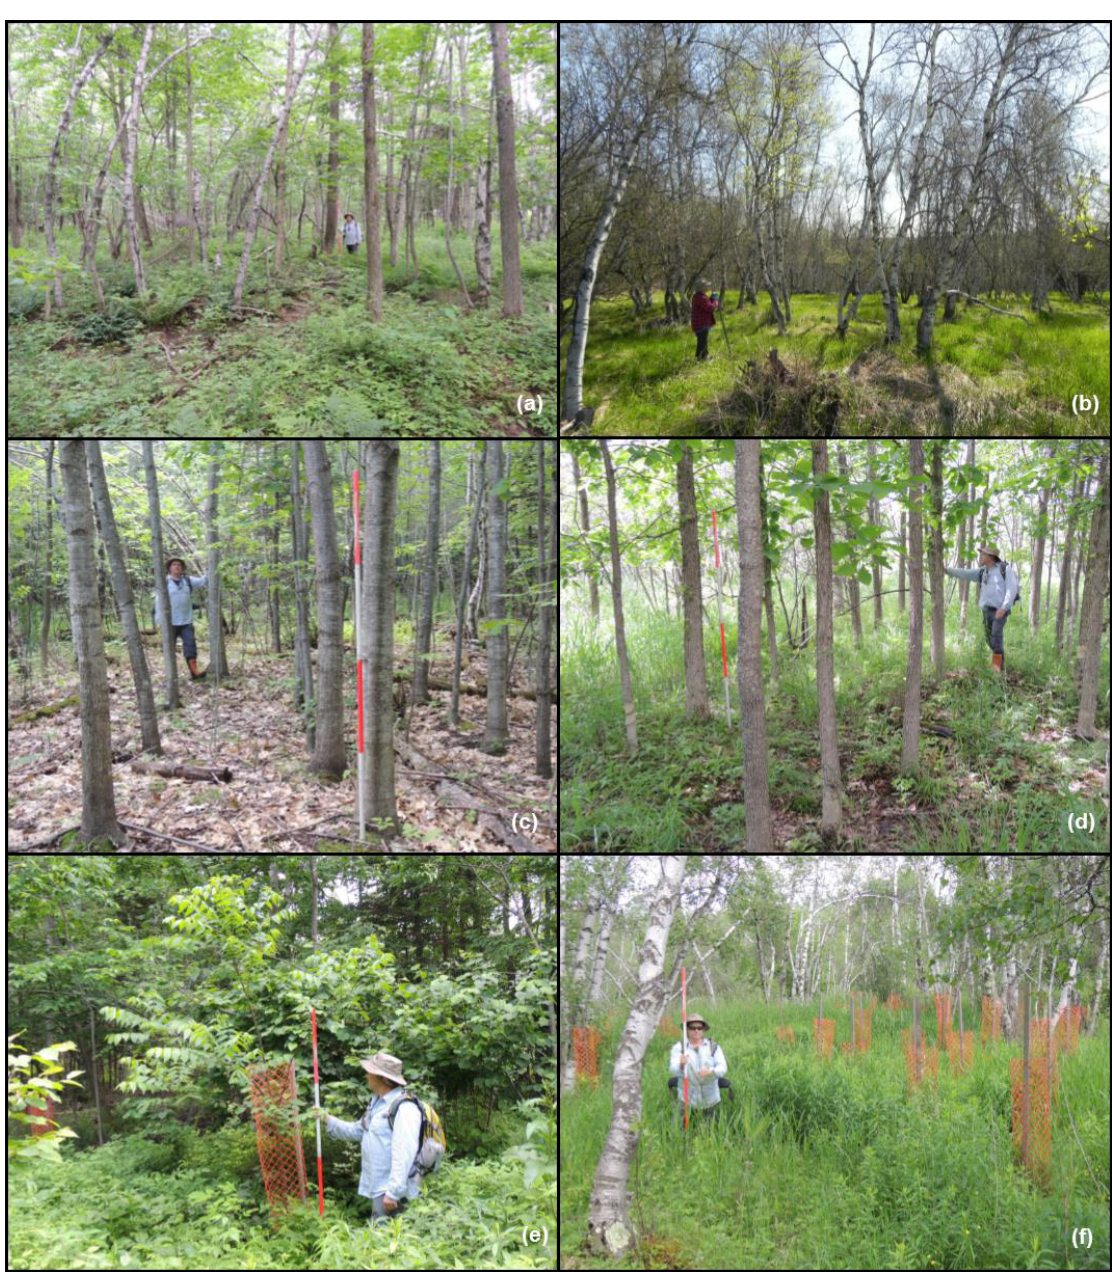
Figure 6. Restoration zones: ( a ) Post-agricultural abandonment stand (mean age: 47 years) of the white ash community type (Y-3); ( b ) Post-agricultural abandonment stand (mean age: 40 years) of the very open grey birch—balsam poplar—elm community type (Y-1); ( c ) Red oak ( Quercus rubra ) planted in the partially cleared understory of an aspen stand in 1991 (24 years old); ( d ) Bur oak ( Quercus macrocarpa ) planted in the partially cleared understory of an alder thicket in 1991 (24 years old); ( e ) Black walnut ( Juglans nigra ) planted in the partially cleared understory of a white ash community type (Y-3) stand in 2012 (3 years old); ( f ) White pine ( Pinus strobus ) planted in the partially cleared understory of a grey birch (Y-1) stand in 2012 (3 years